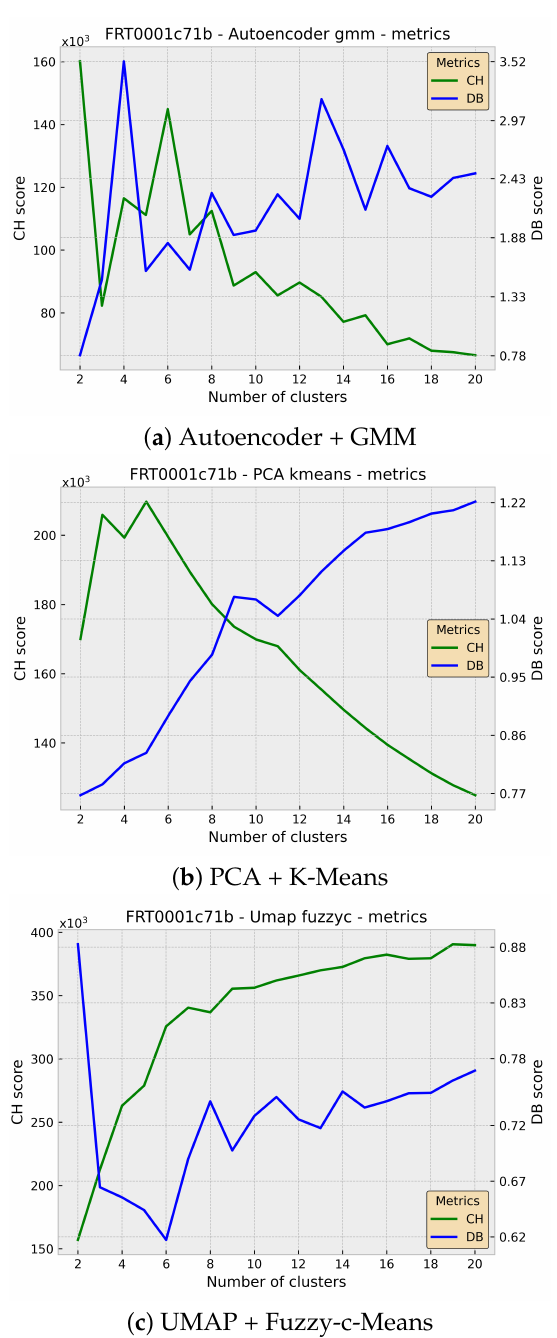
Figure 3. Calinski–Harabasz and Davies–Bouldin index as a function of the number of clusters for the FRT0001c71b dataset. Each subfigure ( a – c ) represents quantitative analysis for the same combinations of the dimensionality reduction technique and clustering algorithm as in Figure